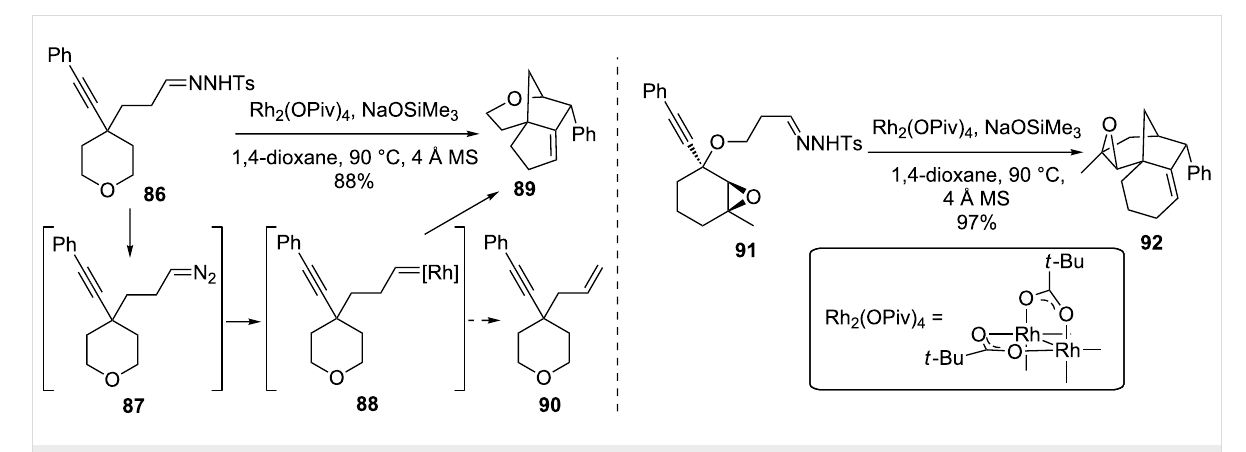
Scheme 19: Conformational effects.